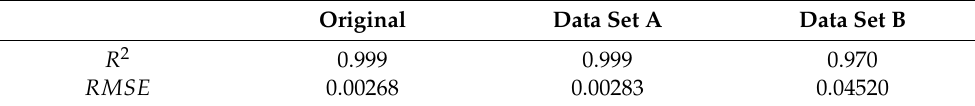
Table 3. Coefficient of determination and RMSE of the random forest regression of the original data set, data set A and